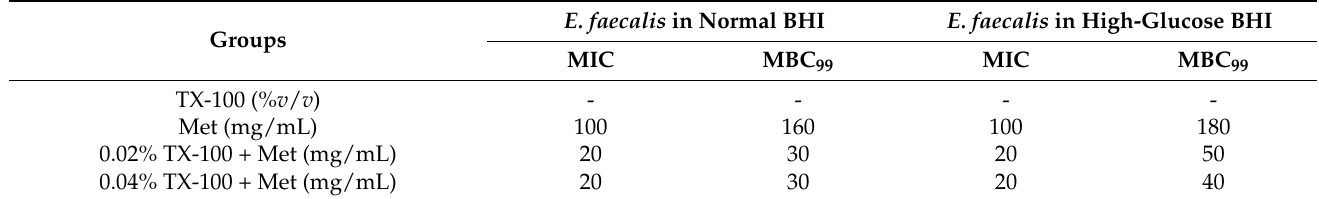
Table 2. Minimum inhibitory concentration (MIC) and minimum bactericidal concentration (MBC 99 ) values of Triton X-100 (TX-100) and metformin (Met) with or without TX-100 against Enterococcus faecalis ( E. faecalis ) in normal and high-glucose BHI. E. faecalis in Normal BHI E. faecalis in High-Glucose BHI Groups MIC MBC 99 MIC MBC 99